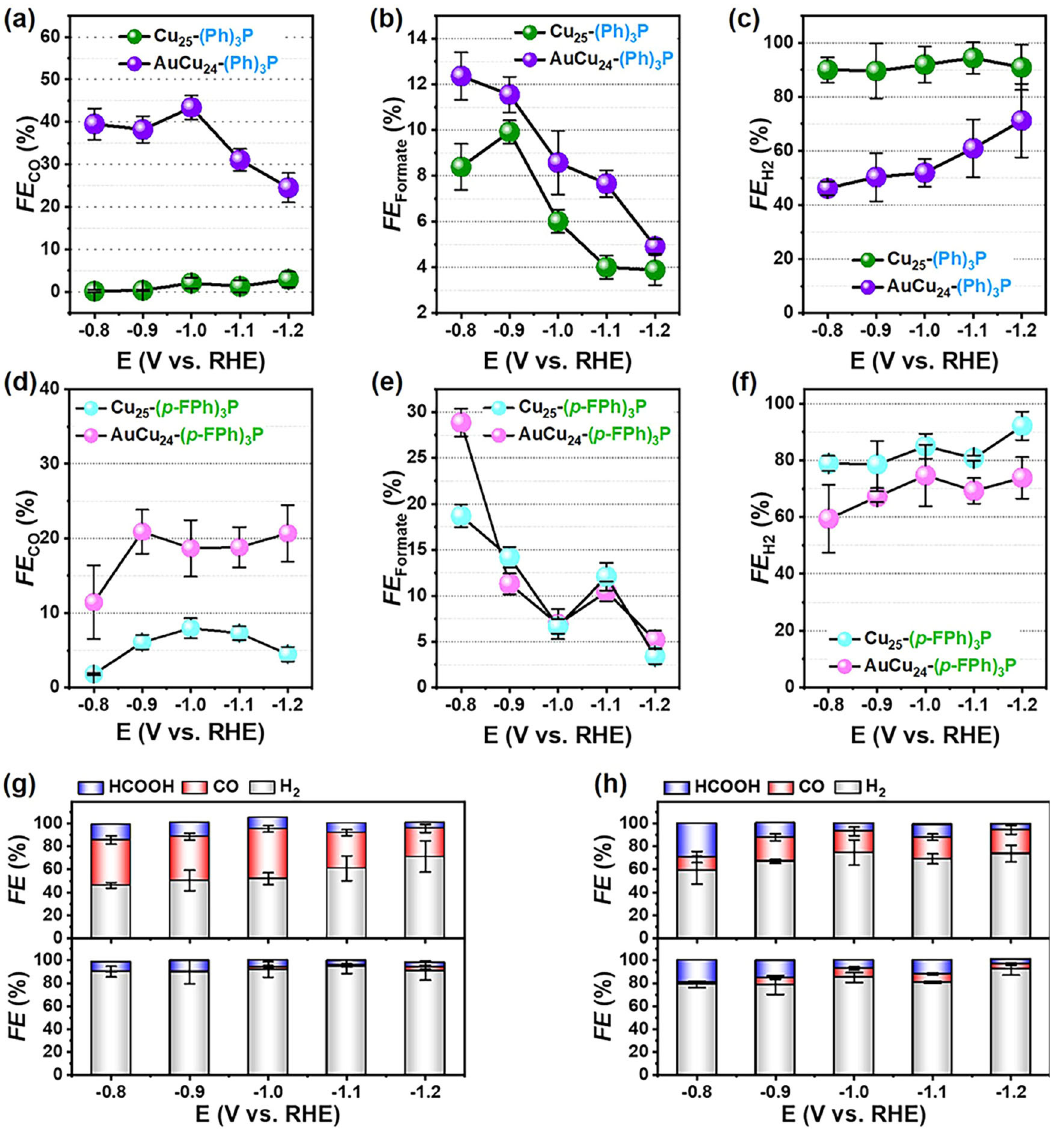
Fig. 2 The electrocatalytic performance of the four M@Cu 24 (M = Au/Cu) NCs in eCO 2 RR. a , d CO, b , e formate and c , f H 2 faradaic ef fi ciency of AuCu 24 -(Ph) 3 P, Cu 25 -(Ph) 3 P, and Cu 25 -( p- FPh) 3 P, AuCu 24 -( p- FPh) 3 P, respectively. FEs for various eCO 2 RR products obtained on g AuCu 24 -(Ph) 3 P, Cu 25 - (Ph) 3 P, and h AuCu 24 -( p- FPh) 3 P, Cu 25 -( p- FPh) 3 P. The error bars represent the standard deviation of three tests at the same test